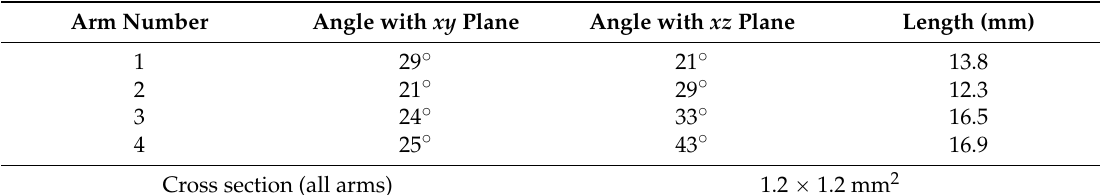
Figure 3. ( a ) 3D model of the expander used for FEA. The individual expander arms have been numbered. Arm 1 is instrumented with the strain gage. ( b ) FEA of strain along the expander arm for an arbitrary expansion. Compressive strain is observed at the location of the strain gage on the sensor arm (arm 1). ( c ) Strain on the top surface of the sensor arm as a function of distance from the fixed anchor. Table 1. Dimensions of the expander arms.